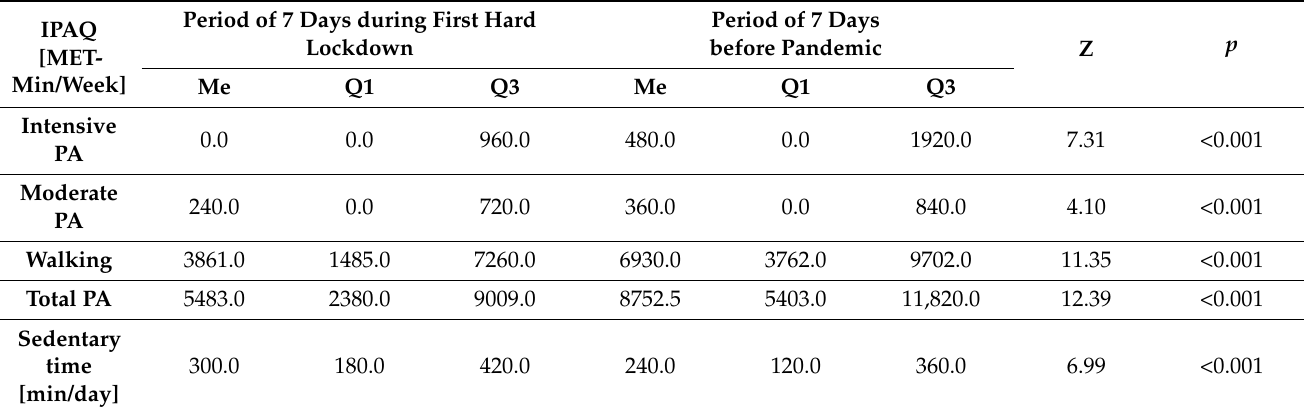
Table 2. The level of physical activity before and during the pandemic.